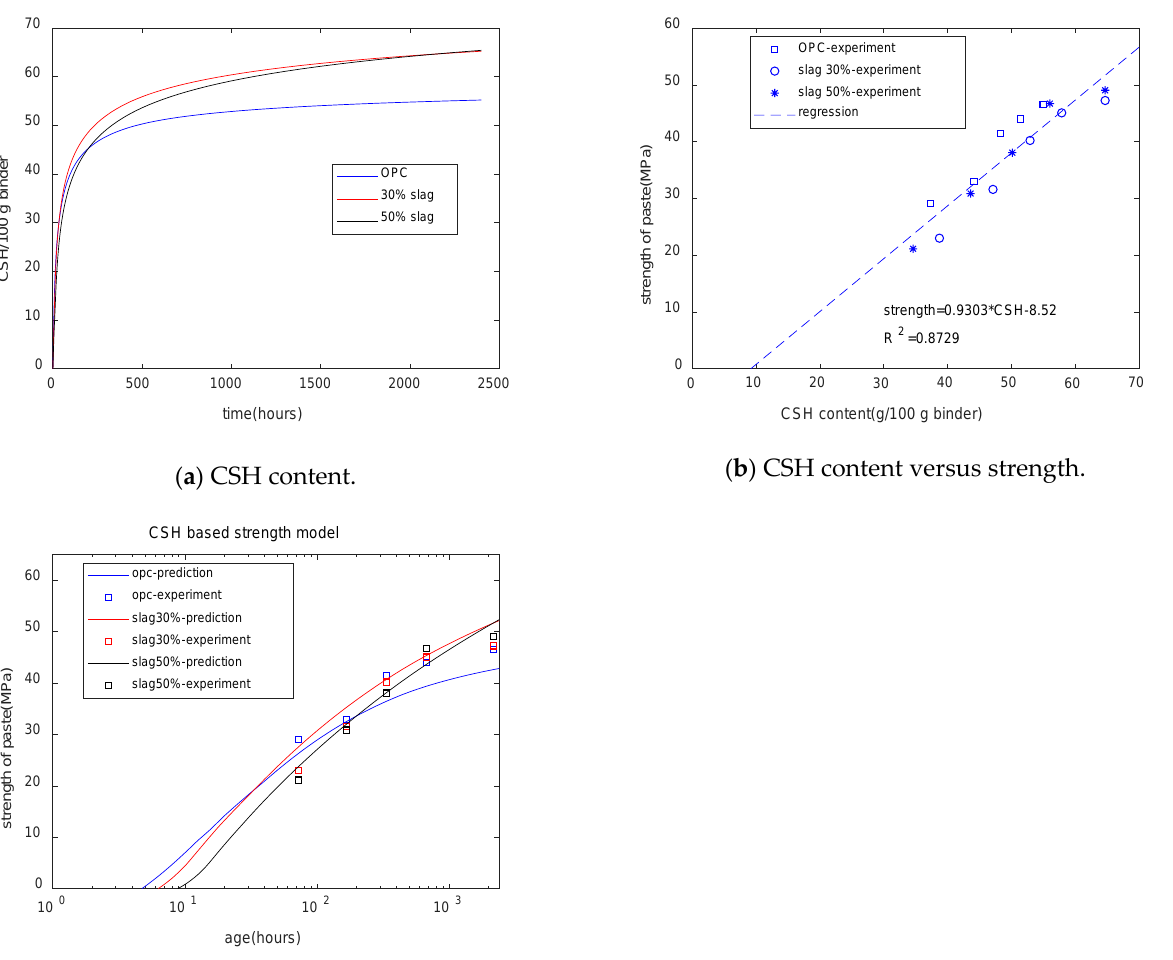
Figure 10. CSH-based strength model.